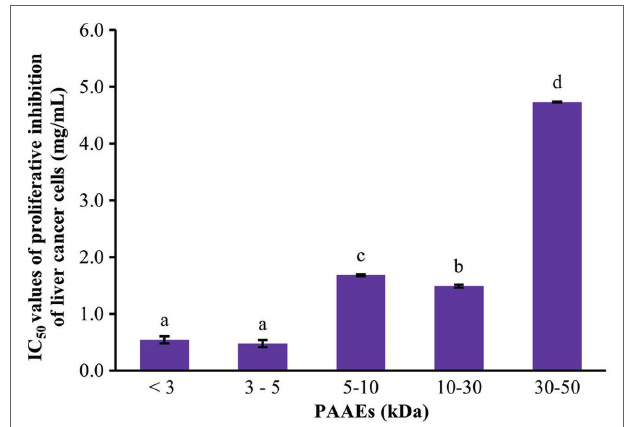
FIGURE 4 | Cytotoxic effect of PAAEs on proliferative inhibition of HepG2 cells. The results were expressed as mean with SD of three replications from three independent studies. a–d The values with different letters appearing show significant differences ( p < 0.05).